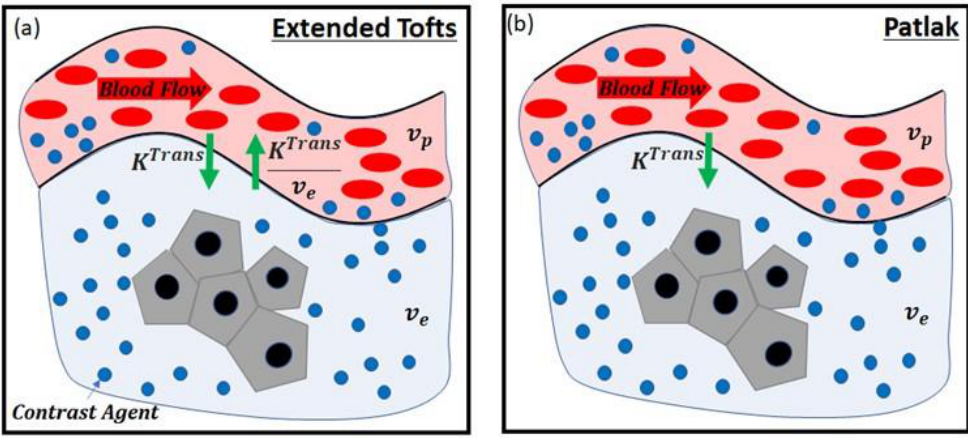
Figure 2. Pharmacokinetic models: ( a ) extended Tofts model, ( b ) Patlak model. 𝐾 𝑇𝑟𝑎𝑛𝑠 , volume transfer constant; 𝑣 𝑒 , extravascular extracellular space volume fraction; 𝑣 𝑝 , blood plasma volume fraction. Table 2. Pharmacokinetic models utilized in each study.